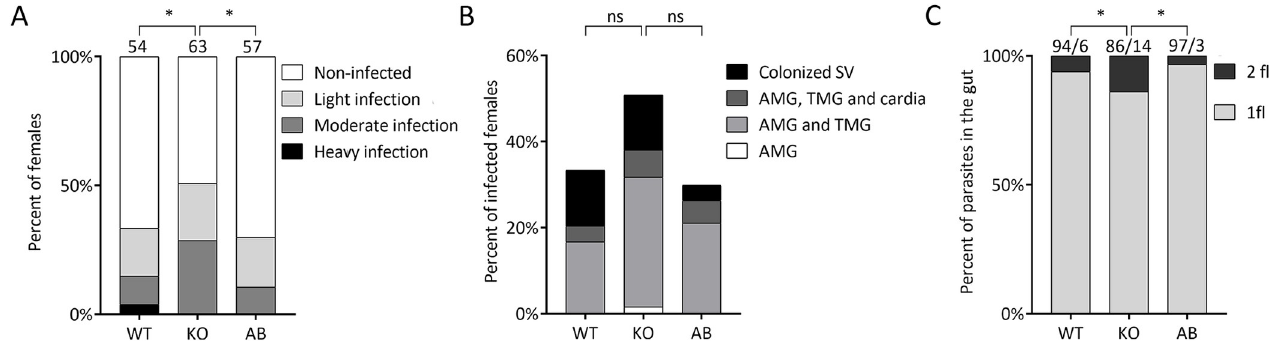
Fig 5. Leishmania guyanensis infection in Lutzomyia longipalpis . Intensity and localization of infection are presented in panels (A) and (B), respectively. Numbers of dissected females are indicated above the bars in A). AMG, abdominal midgut; TMG, thoracic midgut; SV, stomodeal valve. (C) Percent of mono- and bi-flagellated L . guyanensis cells 7- and 9-days p.i. in Lutzomyia longipalpis gut. � – P � 0.05; ns–not significant.